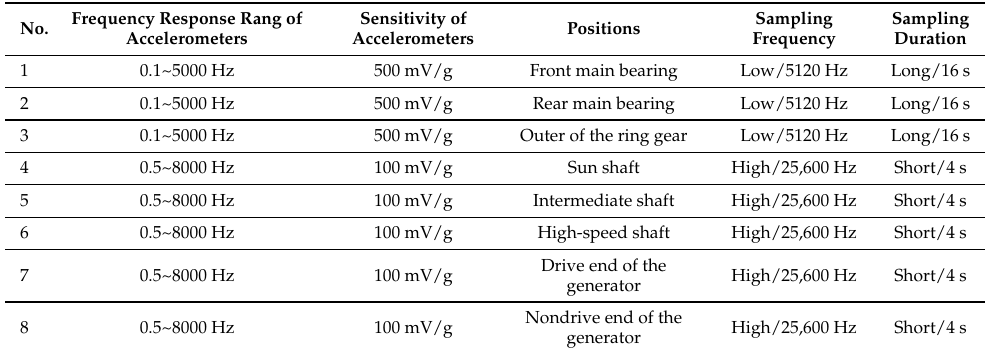
Table 8. Layout of accelerometers of vibration monitoring